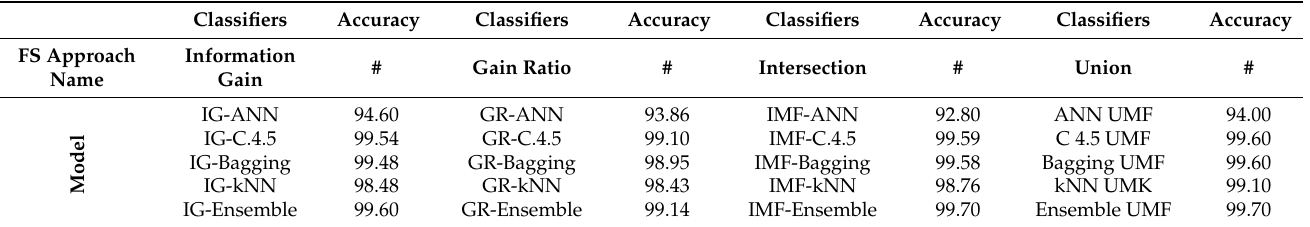
Table 8. Accuracy results yielded by the five various ML with different FS approaches for multi- classification using the IoTID20